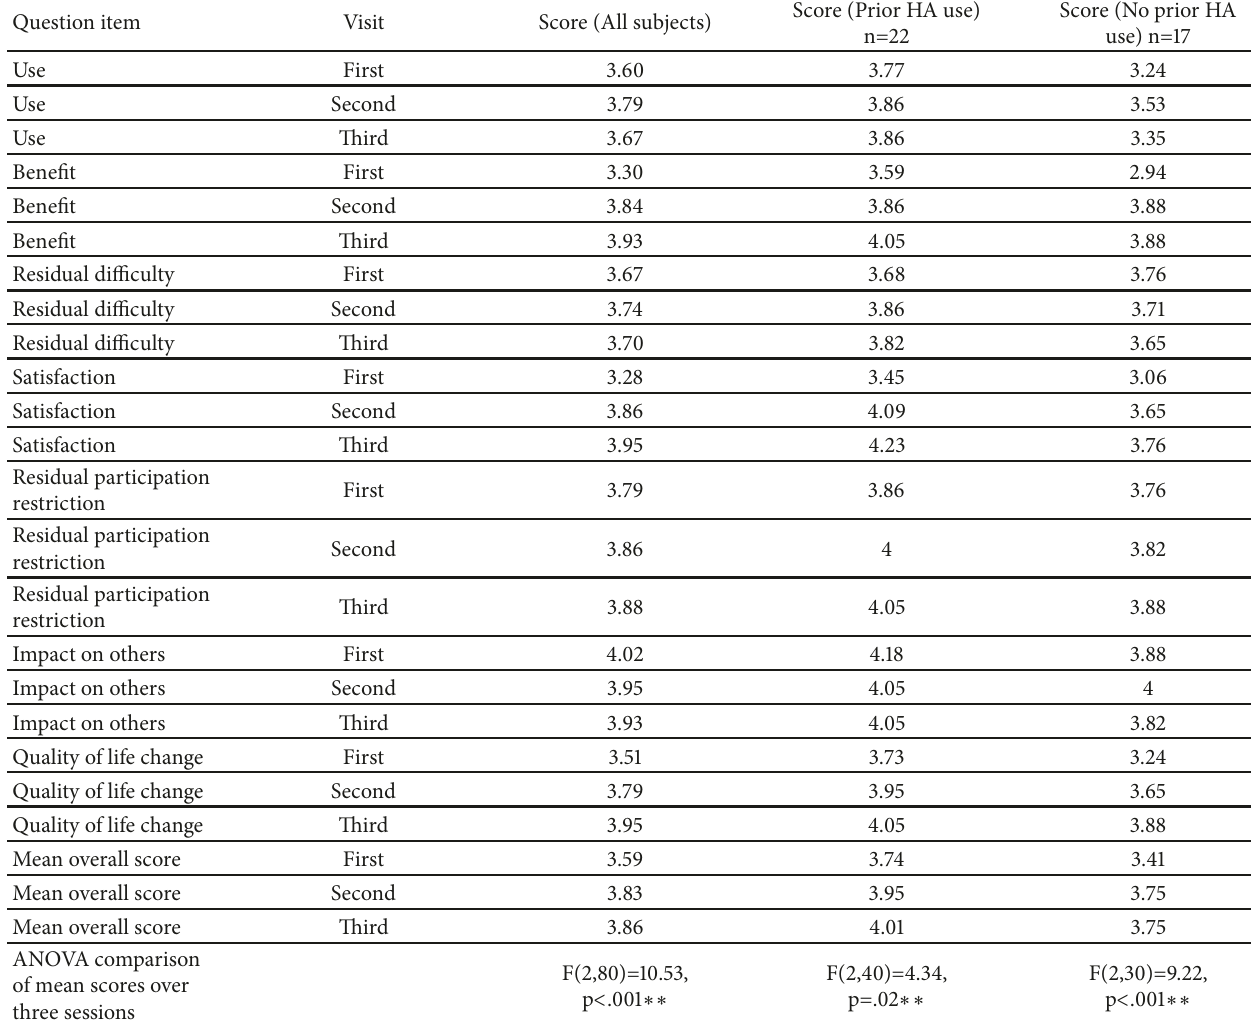
Table 3: IOI-HA scores for all question items for three